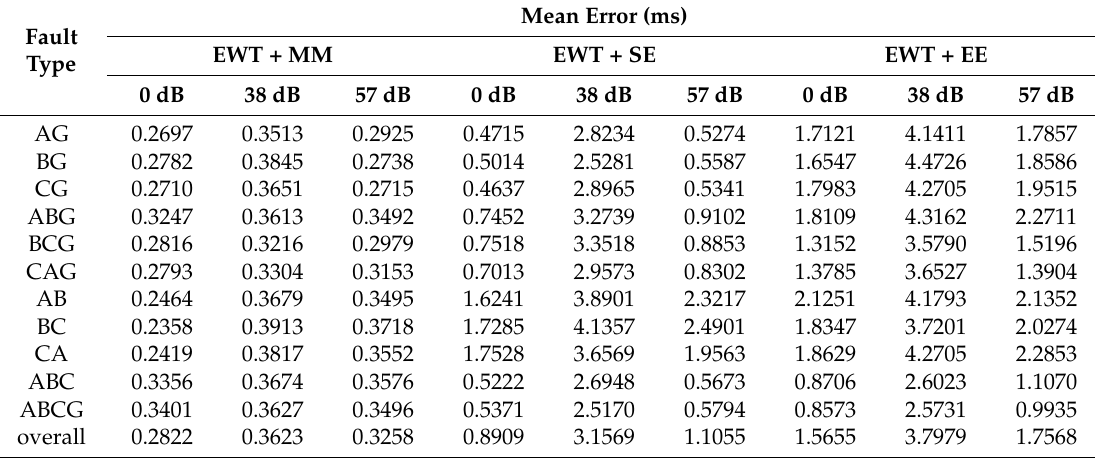
Table 3. The mean fault detection error of different detection methods under different